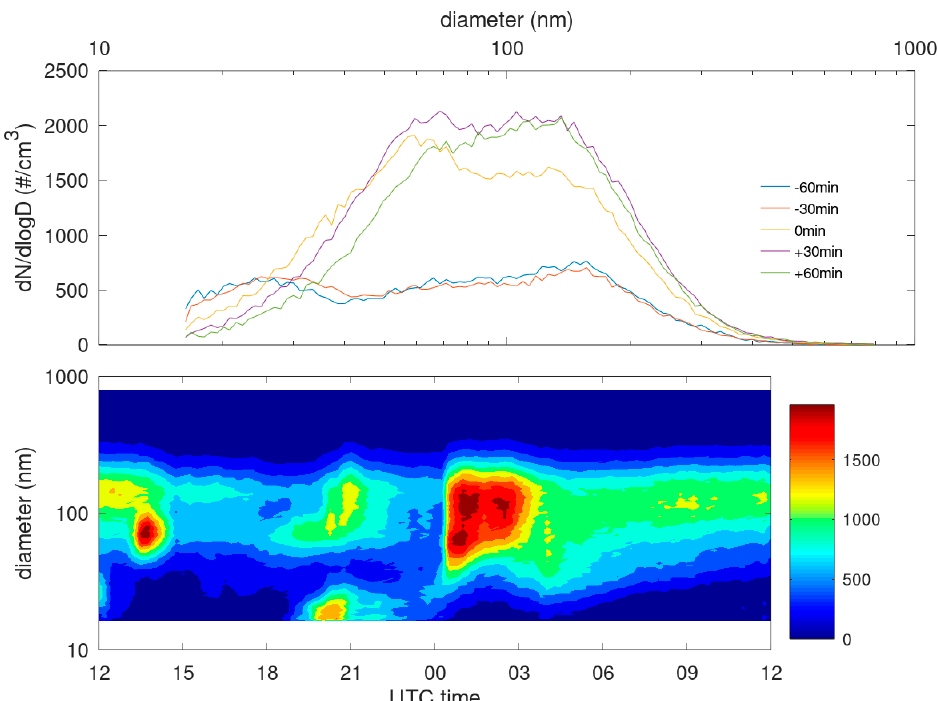
Figure 9. Particle size and concentrations for a sea breeze on 10 March 2021 using an SMPS. The sea breeze passed at approximately 0030 UTC, which coincides with a rapid increase in particle concentrations in the 50–200 nm range. Times in the top plot are relative to the approximate time the sea breeze arrived at the SMPS.